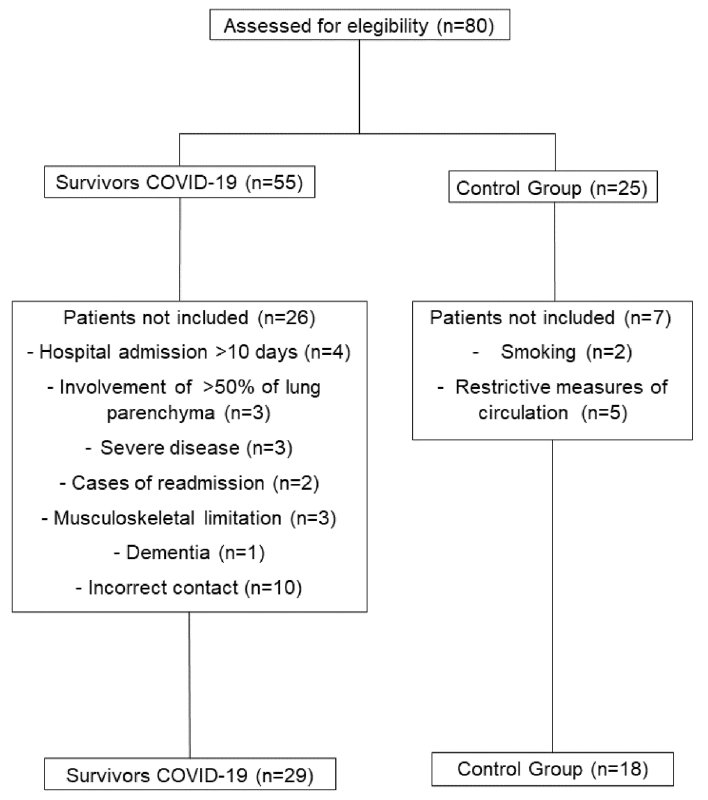
Figure 2. Study fl ow